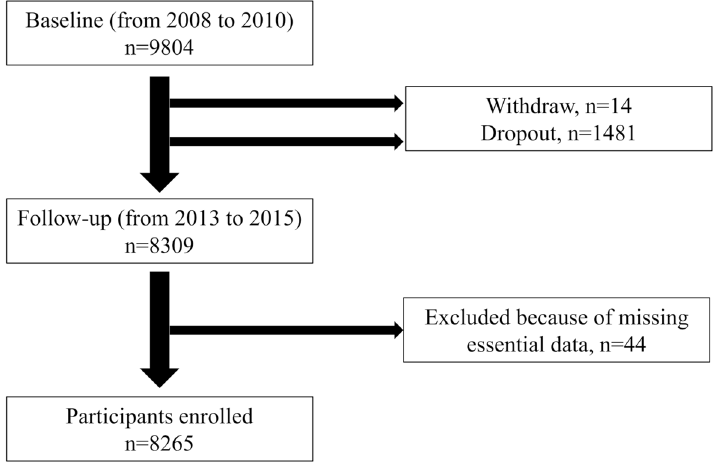
Figure 1. Participants flow diagram. Out of 9804 participants who were surveyed in the baseline assessment, 8265 participants were analyzed in the follow-up